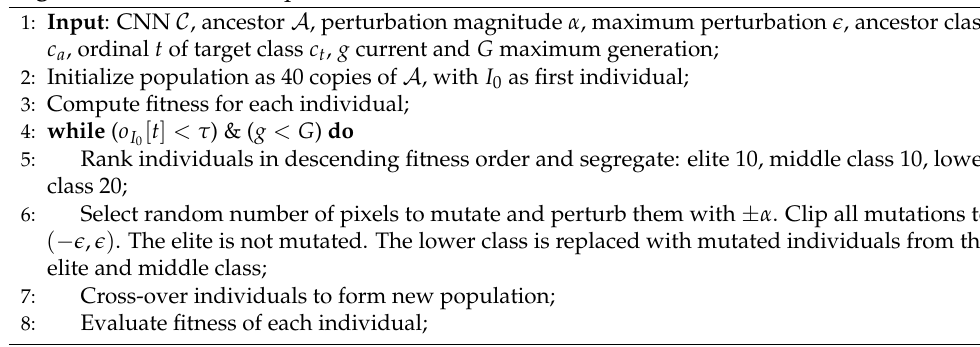
Figure A1. The 100 ancestor images A p q used in the experiments. A p q , pictured in the q th row and p th column (1 ≤ p , q ≤ 10,) is randomly chosen from the ImageNet validation set of the ancestor category c a specified on the left of the q th row. q Algorithm A1 EA attack